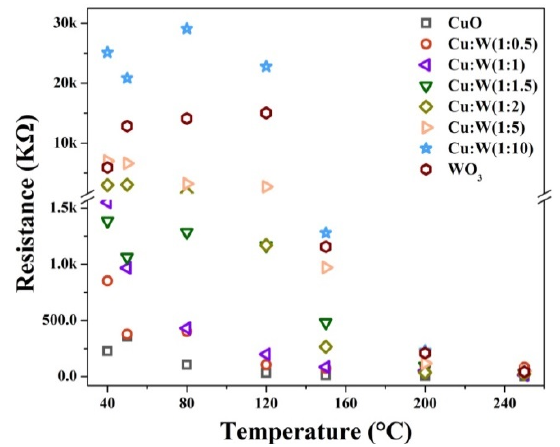
Figure 9. The baseline resistance values of the CuO/WO 3 composites at different operating temperatures.